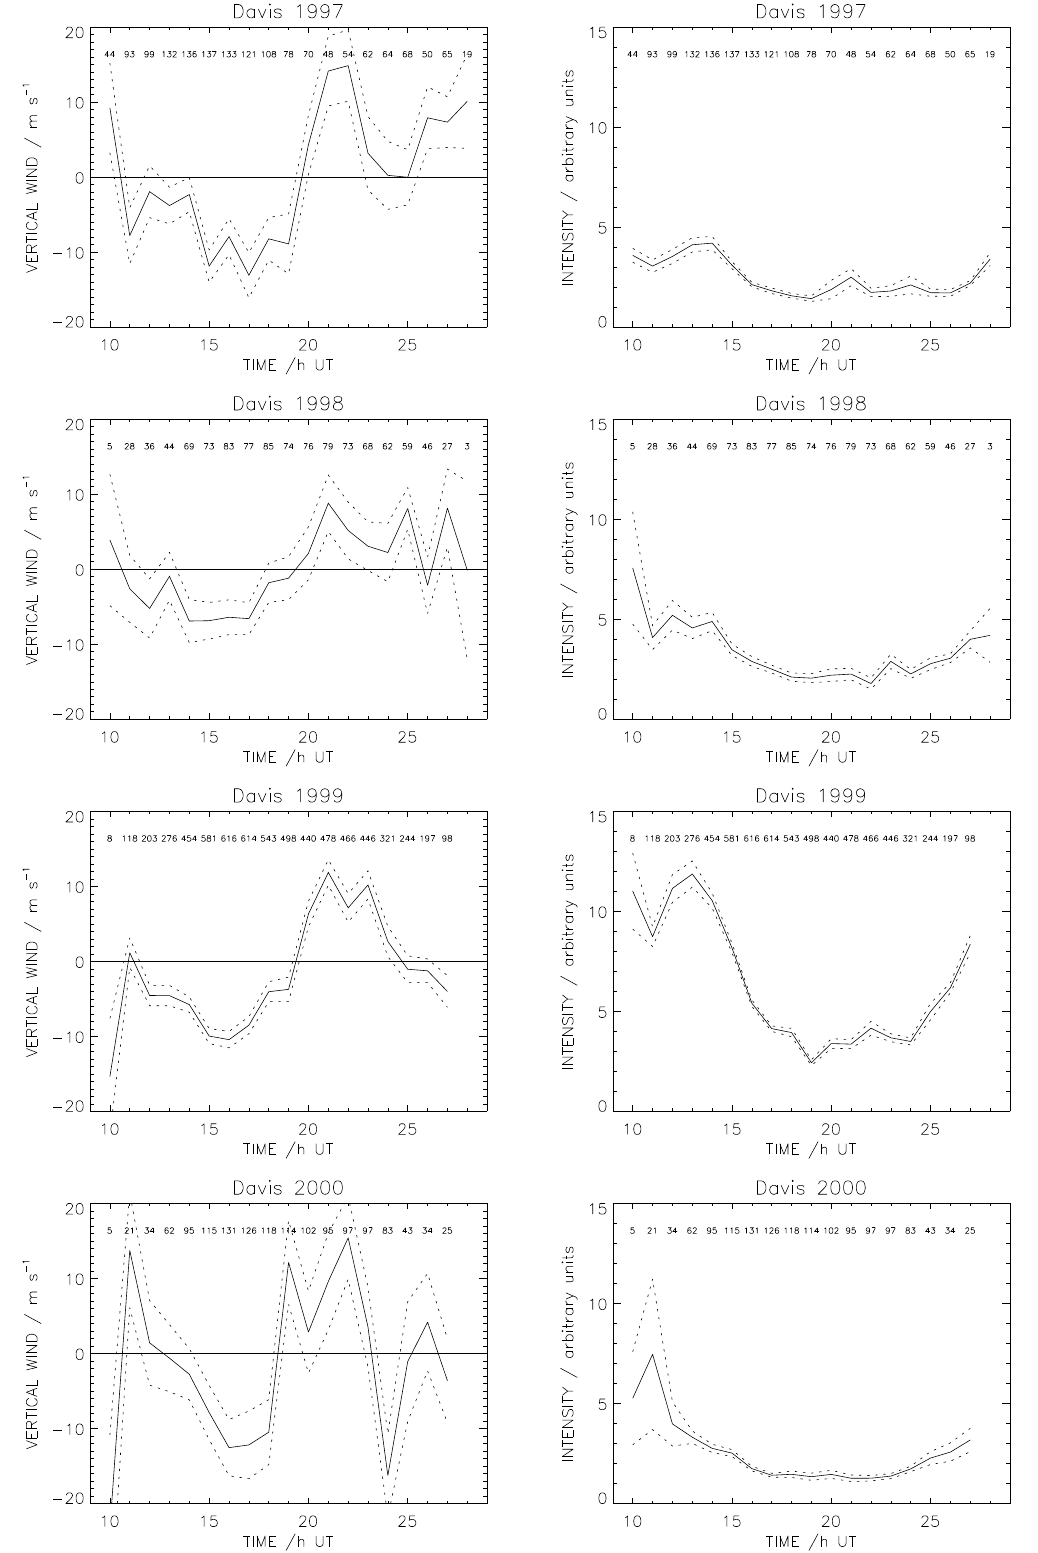
Fig. 1. Hourly averaged vertical wind and intensity for Davis, for the years 1997–2000. Standard errors in hourly means are indicated by dashed lines. The number of points in each hourly mean is written at the top of each